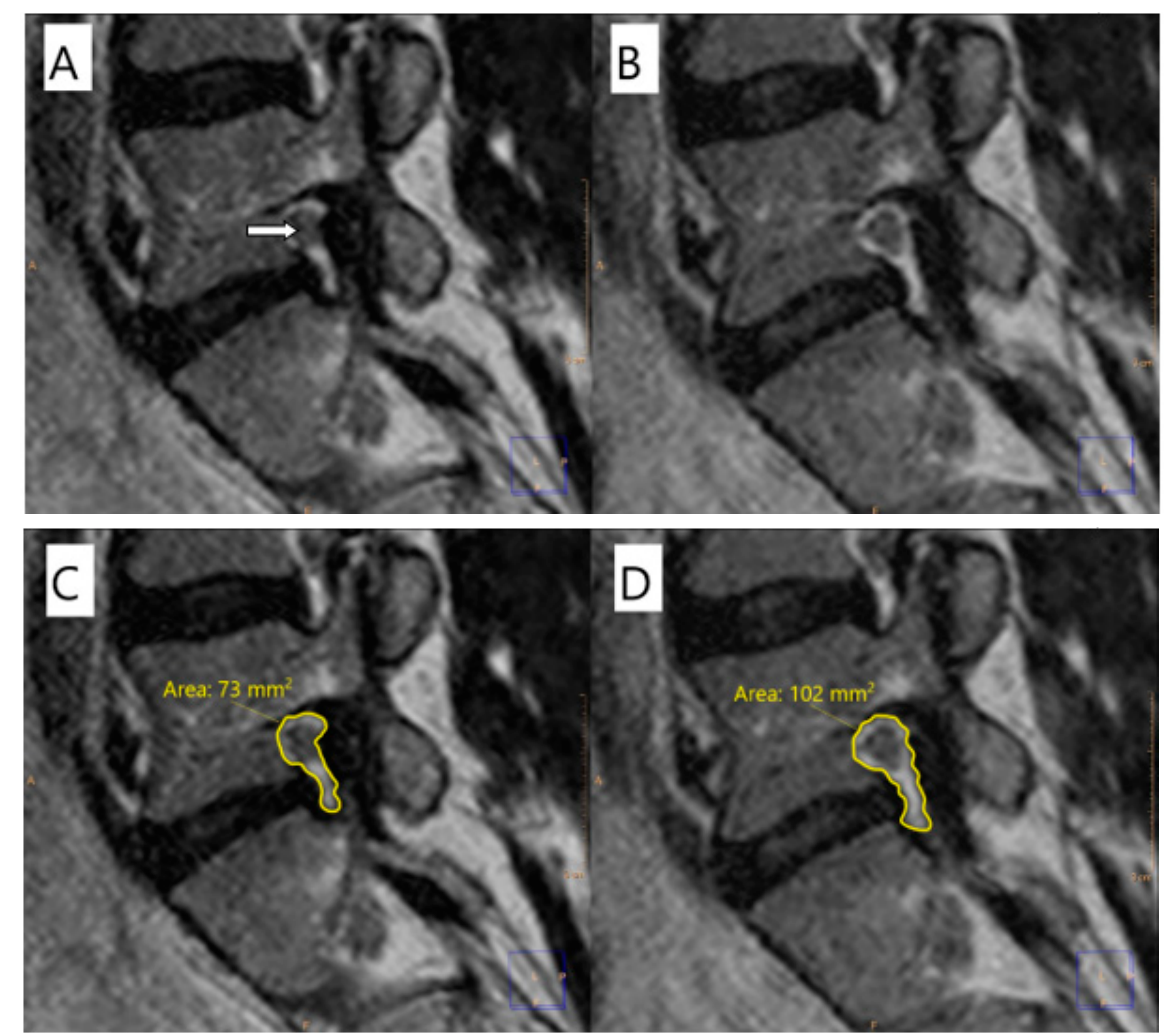
Figure 5. Sagittal magnetic resonance cross-section through the L2–L3 foramen. ( A ) Unloaded MRI shows normal relationships between the foramen and surrounding structures with no perineural fat obliteration nor root morphological changes; ( B ) axial-loaded MRI shows perineural fat obliteration surrounding the nerve root in the transverse direction (arrow); changes in the area of the intervertebral foramen at L2–L3 seen without ( C ) and with ( D ) axial loading.